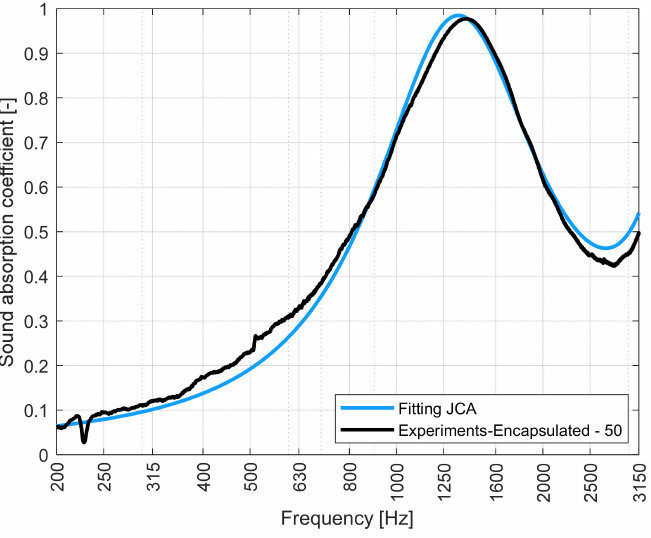
Figure 13. Comparison between experimental and predicted sound absorption coefficient for the sample made of encapsulated